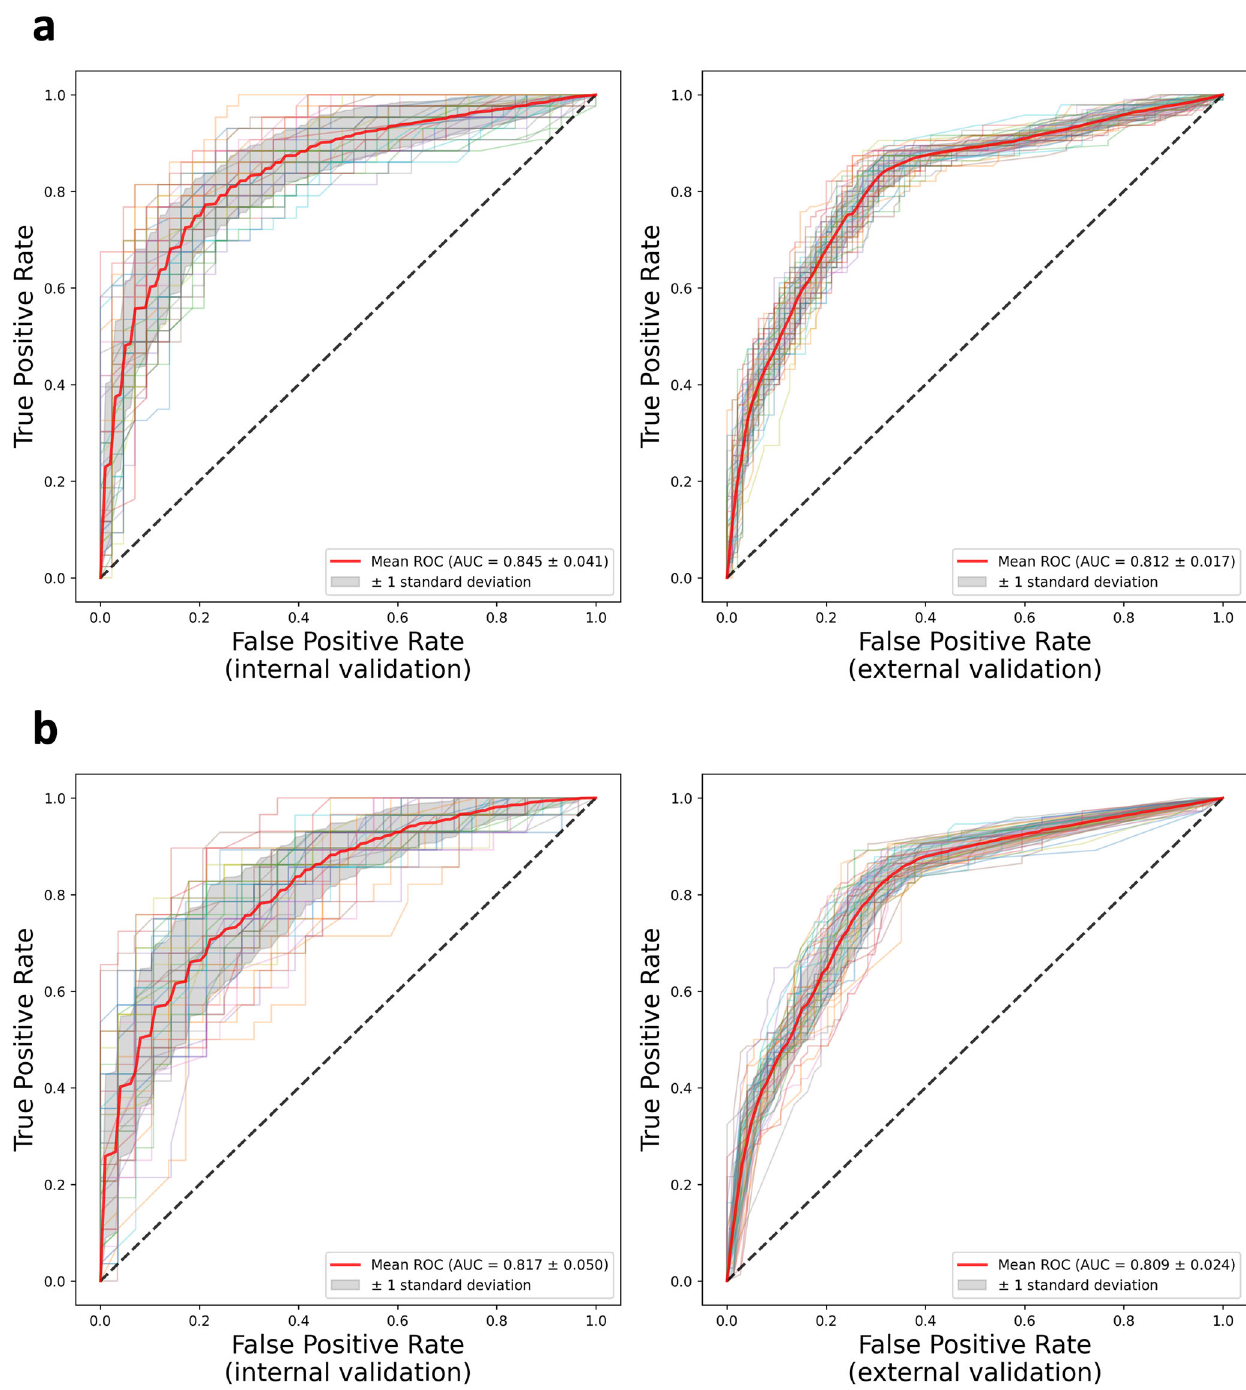
Fig. 4 ROC curves with 50 repeats for the binary recurrence classi fi cation by GB models. a ROC curves in internal and external validations with the original cohorts. b ROC curves in internal and external validations with the core complete cohorts: negative or not indicated regional lymph node histology, known mitotic rate, and known ulceration. Consistent results between the original and core complete cohorts are cohorts. In the complete cohorts, the number of recurrences was When experimenting on the core complete cohorts, the 116 in the MGB cohort and 45 in the DFCI cohort. The time- prediction performance of the GB-T model deteriorated signi fi - dependent AUC and concordance index of the GB-T model were cantly in the internal validation (time-dependent AUC: 0.853 vs. further reduced in both internal (time-dependent AUC: 0.808, 0.829; concordance index: 0.820 vs. 0.788; p -values: <0.001) and concordance index: 0.768) and external (time-dependent AUC: decreased slightly in the external validation (time-dependent AUC: 0.673, concordance index: 0.752) validations. In the external 0.820 vs. 0.804, p -value: <0.001; concordance index: 0.820 vs. validation, the best time-dependent AUC (0.692) achieved by the 0.808; p -value: 686) compared to the performance of the original